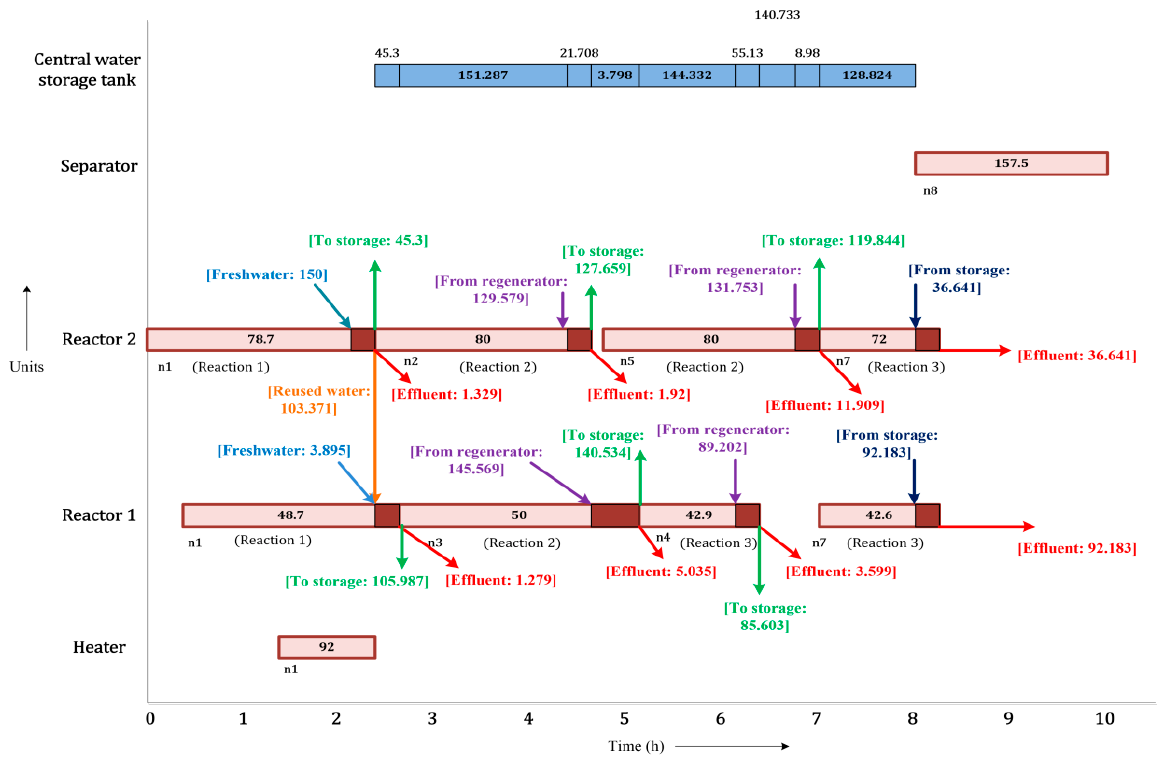
Figure 13. Gantt chart obtained for the simultaneous approach for case study 3 with water storage tank and regenerator.